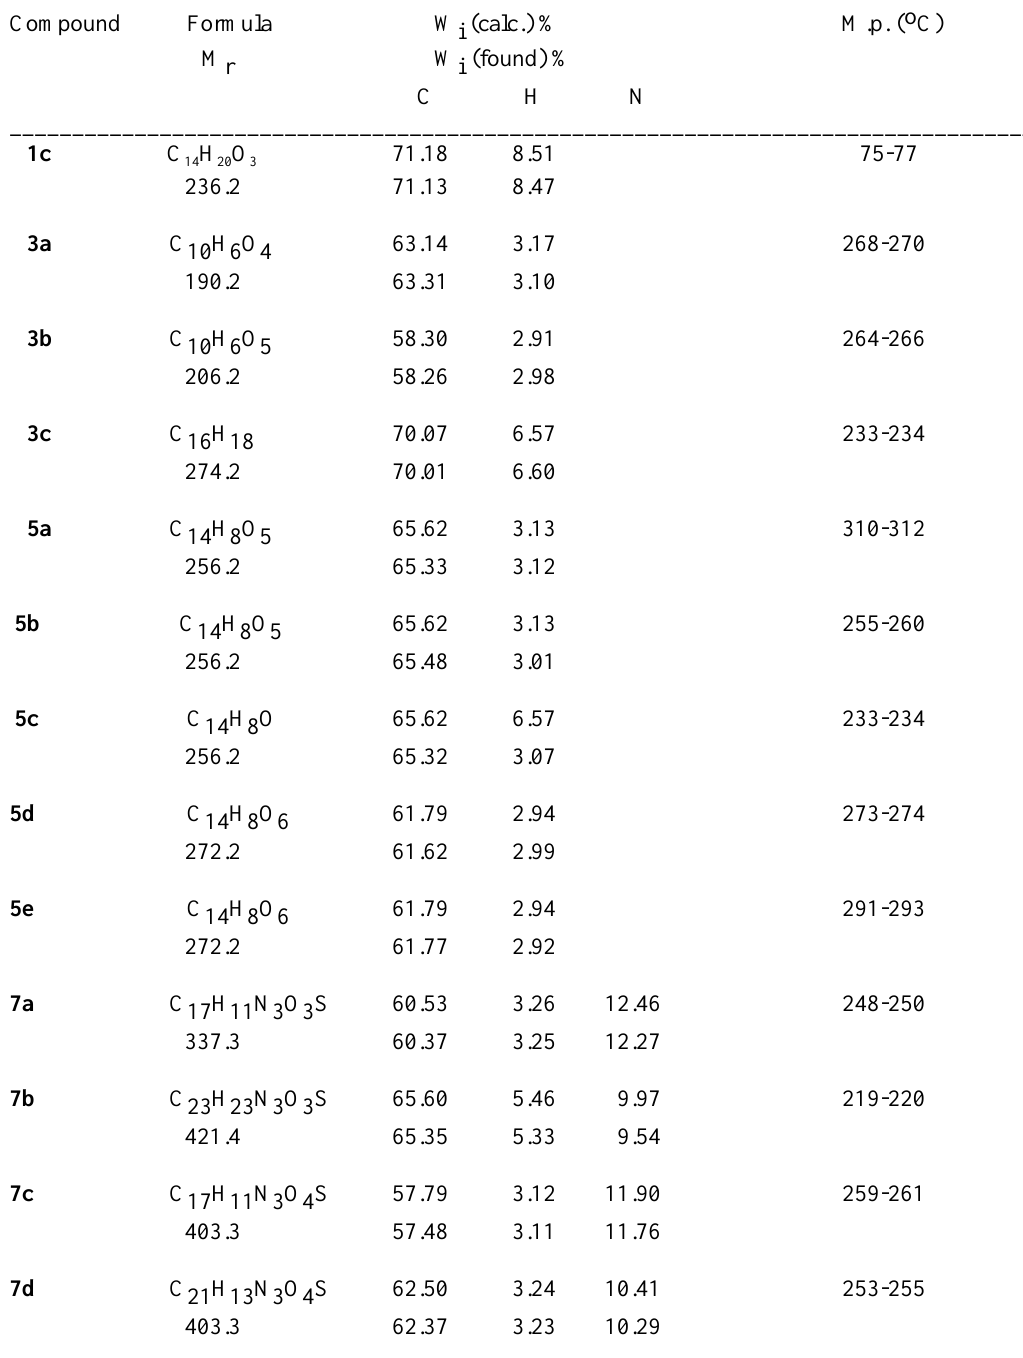
Table 1 . Elemental analysis data of prepared